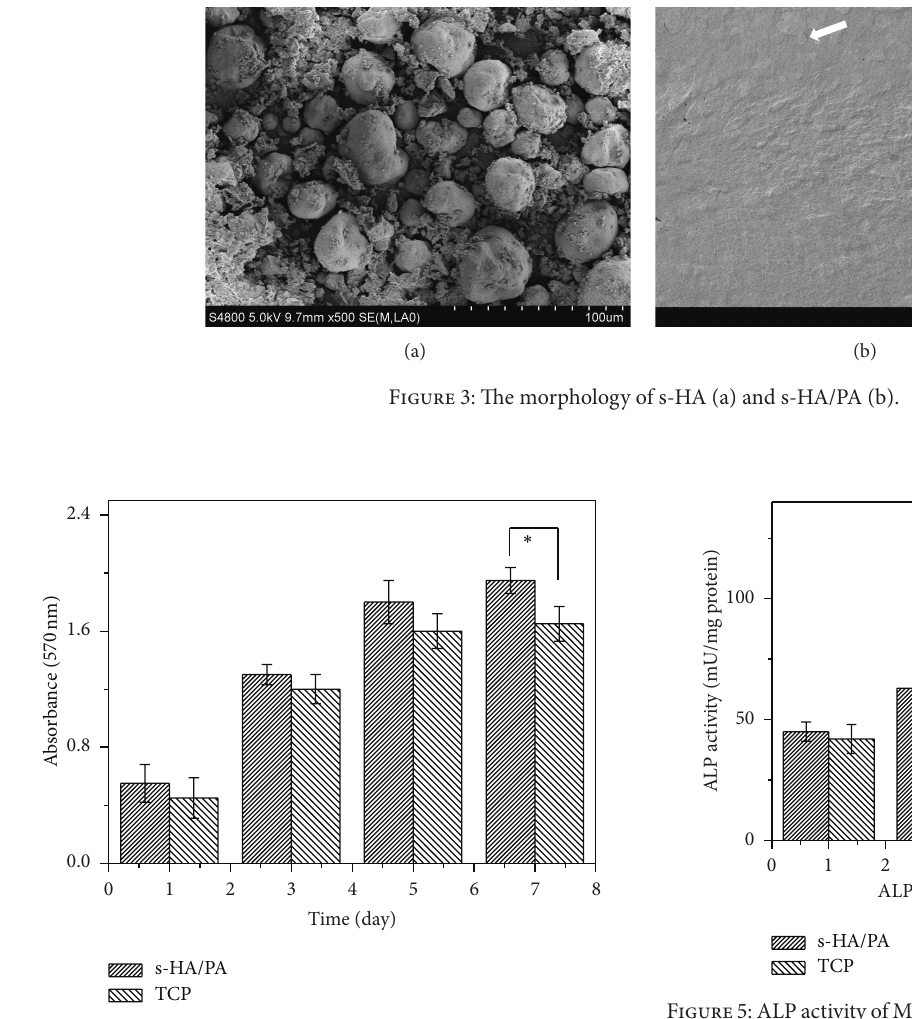
Figure 4: Viability of MG63 cells on s-HA/PA composite by MTT assay, TCP as controls, ∗ 𝑃 < 0.05 .